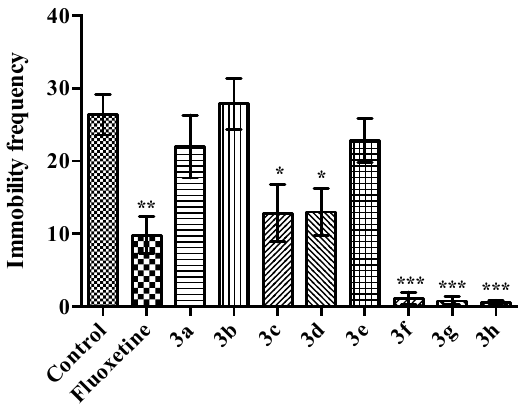
Figure 2. The effects of the test compounds 3a – 3h (40 mg/kg) and fluoxetine (20 mg/kg) on the immobility frequencies of the mice in MFST. Significant differences versus control values, * p < 0.05, ** p < 0.01, *** p < 0.001. Values are given as mean ± SEM, ( n = 6).